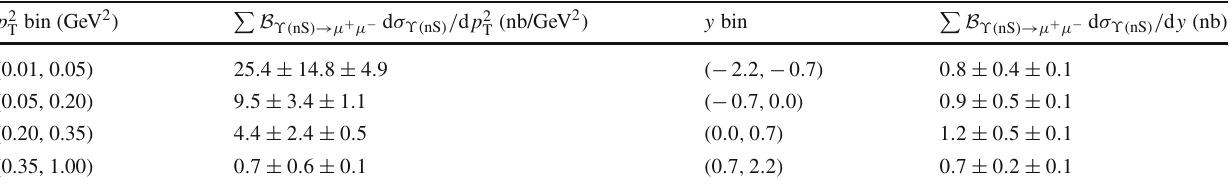
Table2 Differentialexclusive ϒ( nS ) → μ + μ − photoproduction crosssectionsinfour p 2 to statistical and systematic components, respectively p 2 bin (GeV 2 ) T